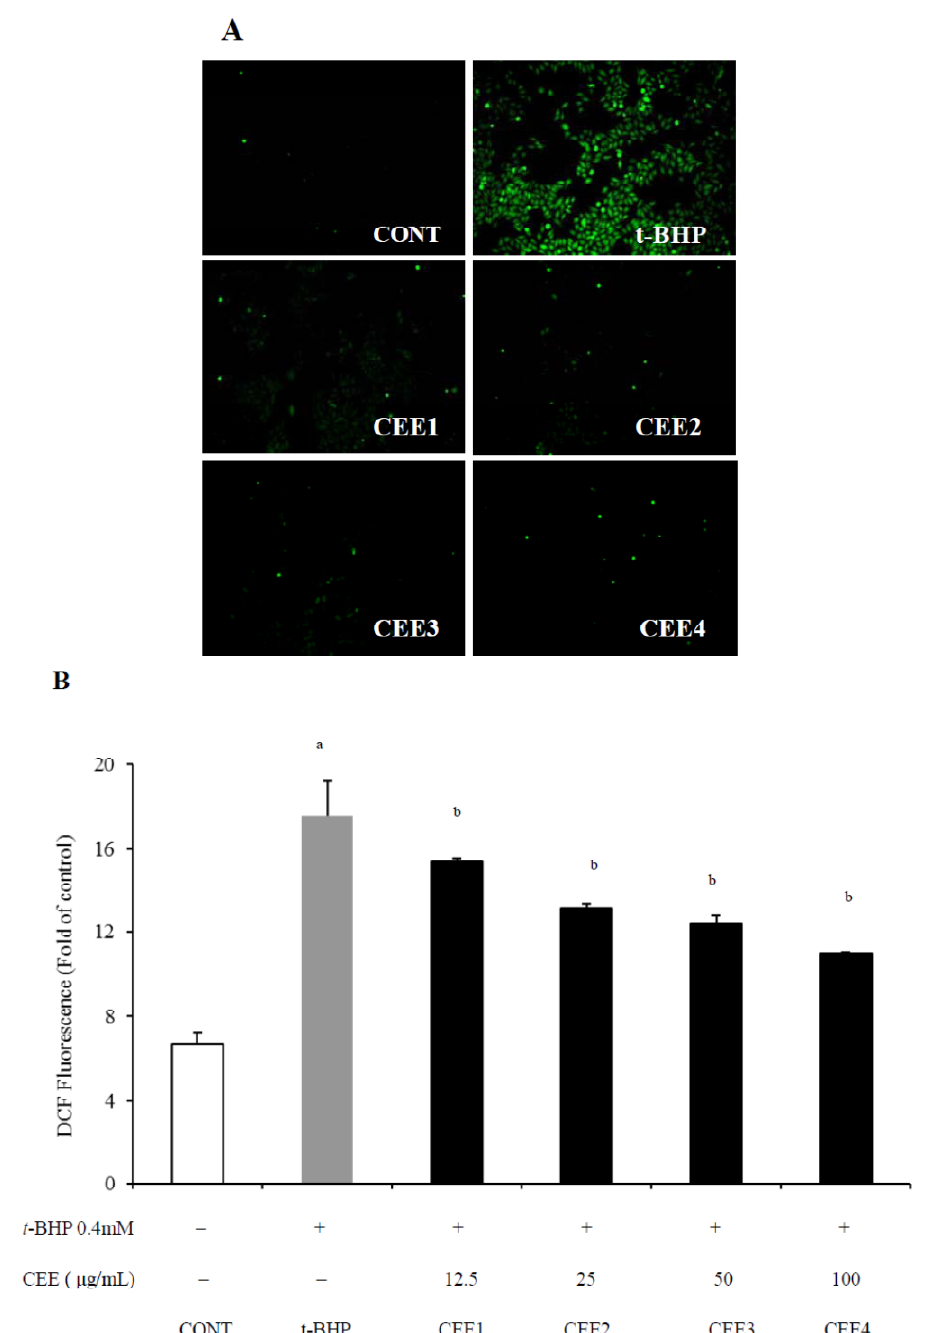
Figure 2. Effect of CEE on ROS Production in t -BHP treated HepG2 cells (N = 3). Cells were co-treated with t -BHP (0.4 mM) and CEE (12.5, 25, 50, or 200  g/mL) for 1 h. The fluorescent probe DCFH-DA (50  M) was added 30 min before monitoring the level of intracellular ROS with ( A ) a fluorescence microscope and ( B ) fluorometer. DCFH-DA staining, magnification 100×; a p < 0.01, compared with control group. b p < 0.01, compared with t -BHP-treated cells. CONT : Non-treated control cells, t -BHP : t -BHP treated cells; CEE1 , 2 , 3 and 4 represent 12.5, 25, 50, and 200  g/mL of CEE, respectively. CEE: Cichorium endivia L. extracts; DCFH-DA: 2 ′ ,7 ′ -dichlorofluorescin diacetate; t -BHP: tert -butyl